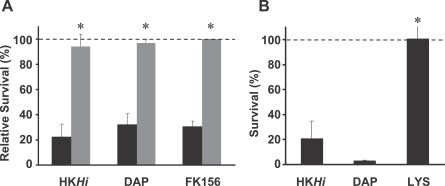
The Ability of Synthetic Peptidoglycan Fragments to Stimulate Opsonophagocytic Killing of Sp
(A) Neutrophil-enriched PECs were obtained from C57Bl/6 (black bars) or congenic Nod1−/− (grey bars) mice pretreated by i.p. administration of casein containing heat-inactivated whole Hi636 (HKHi), murNAcTRIDAP (DAP, 10 μg/animal), or its synthetic analog, FK-156 (10 μg/animal). Survival of Sp1121 is shown relative to controls where neutrophil-enriched PECs were elicited by casein administration alone. Values represent ≥ three independent determinations in duplicate ± SD. *p < 0.01 compared to the same treatment in parental mice.(B) Neutrophil-enriched PECs were obtained from C57Bl/6 mice pretreated by i.p. administration without casein of heat-inactivated whole Hi636 (HKHi), murNAcTRIDAP (DAP, 10 μg/animal), or murNAcTRILYS (LYS, 10 μg/animal).Values represent ≥ three independent determinations in duplicate ± SD. *p < 0.01 compared to other groups.